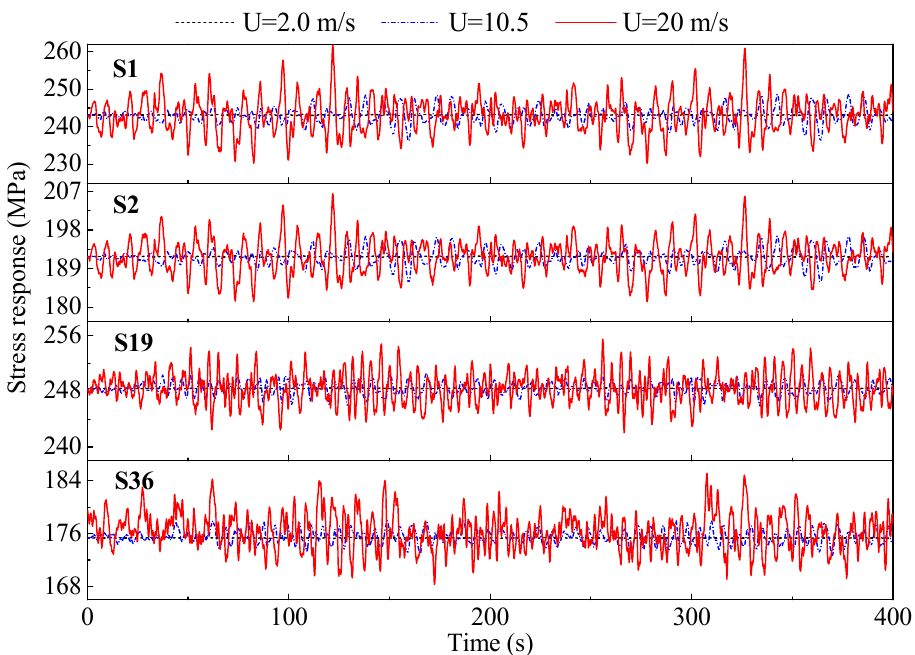
Figure 8. Segment of stress response time histories of representative suspenders under various wind speeds.